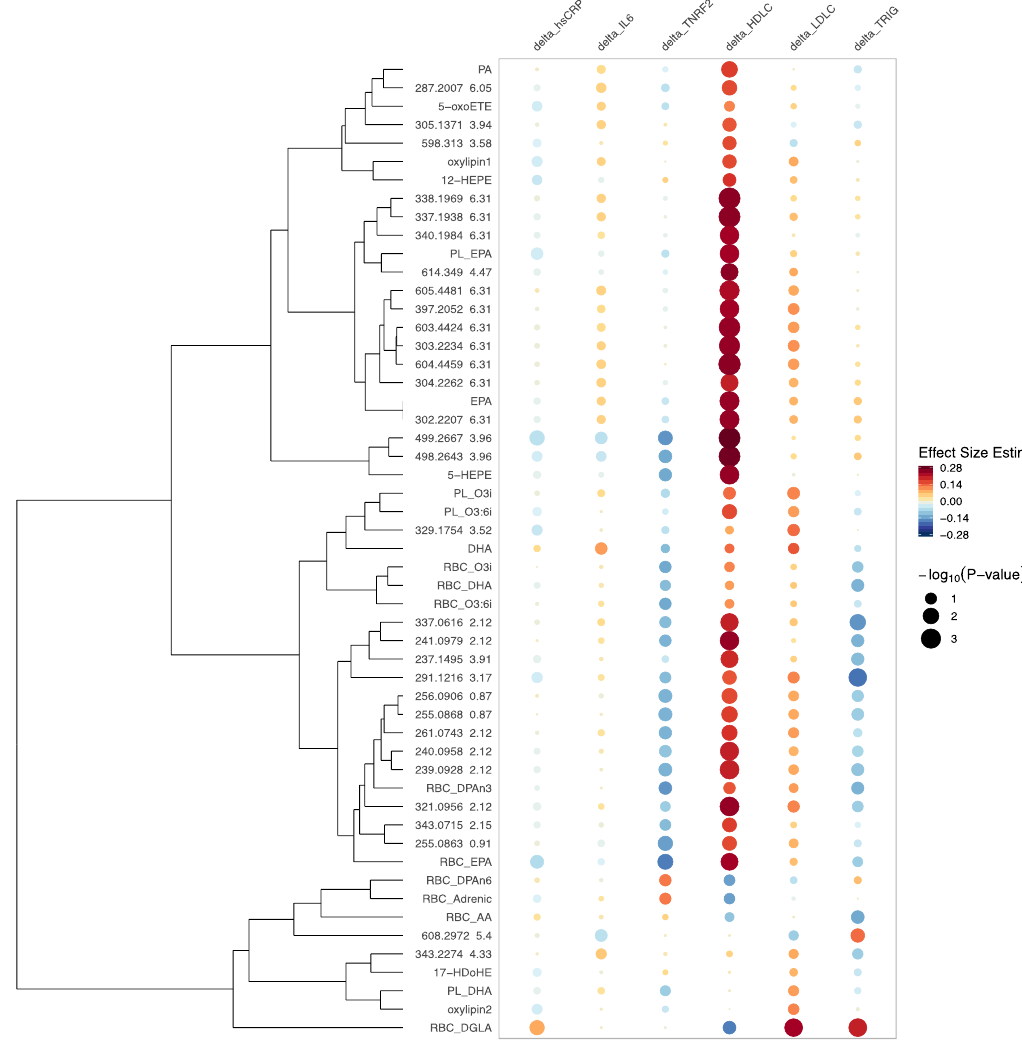
Figure 6. Rainplot [17] of beta coefficients of the significant associations of one-year changes in clinical biomarkers (high-sensitivity C-reactive protein (hsCRP), interleukin-6 (IL6), tumor necrosis factor receptor 2 (TNRF2), HDLC, low-density lipoprotein cholesterol (LDLC) and triglycerides) with one-year changes in FAs, oxylipins and bioactive lipid features controlling for age, sex and race. Only significant with n-3 treatment and annotated FAs, oxylipins and bioactive lipids are reported here as well as 30 out of 143 most significant un-annotated bioactive lipid features (labeled with m / z and RT) with respect to their association with n-3 treatment. “PL_” in front of the name means that compound was measured by plasma PL assay; “RBC_” in front of the name means that it was measured by RBC assay; otherwise the LCMS assay was used. Assays: LCMS—high-throughput liquid chromatography–mass spectrometry of circulating free FAs, oxylipins and bioactive lipids in plasma; RBC—gas chromatography with flame ionization detection for red blood cells; PL—LCMS2 plasma phospholipids. PA—palmitic acid, oxylipins 1,2 could not be annotated due to the lack of the standard in the library, they are novel oxylipins reported in [12].